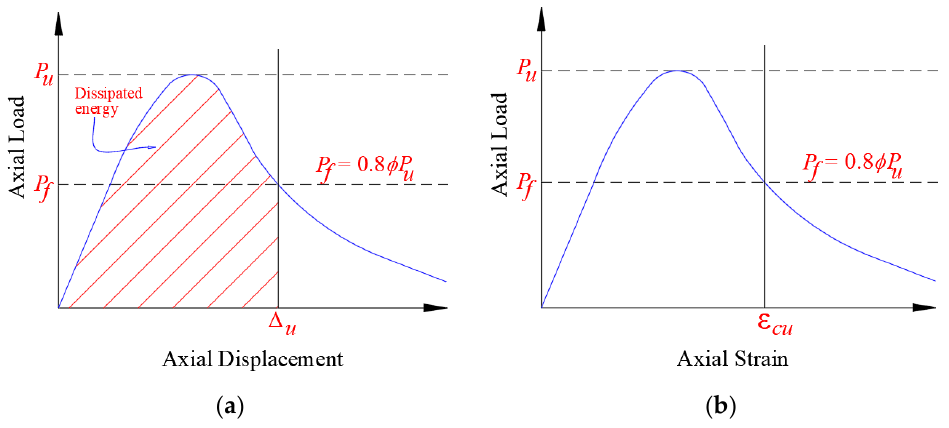
Figure 10. Definition of ultimate state for test columns: ( a ) dissipated energy; ( b ) ultimate axial concrete strain. Table 3. Comparison of experimental and FE results of load-displacement response for test col- umns*.